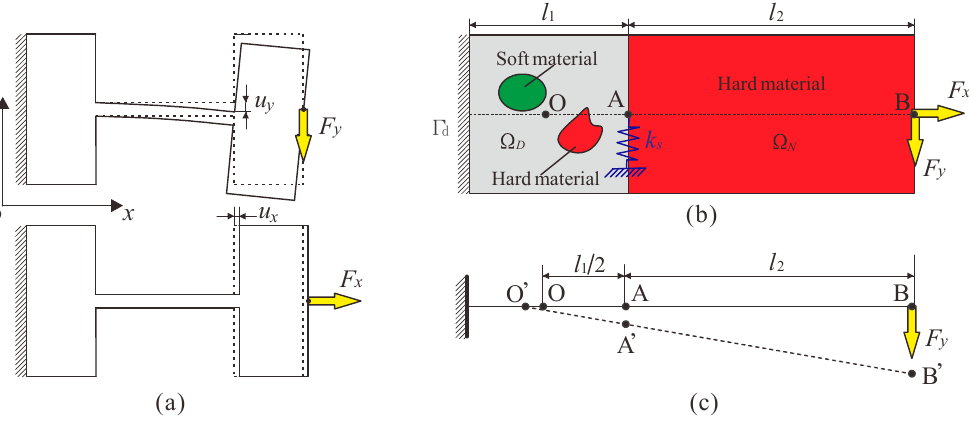
Figure 3. General formulation for multi-material topology optimization of flexure hinge. ( a ) A flexure hinge with boundary conditions and loads, ( b ) design domain, ( c ) schematic diagram of rotation center constraint.